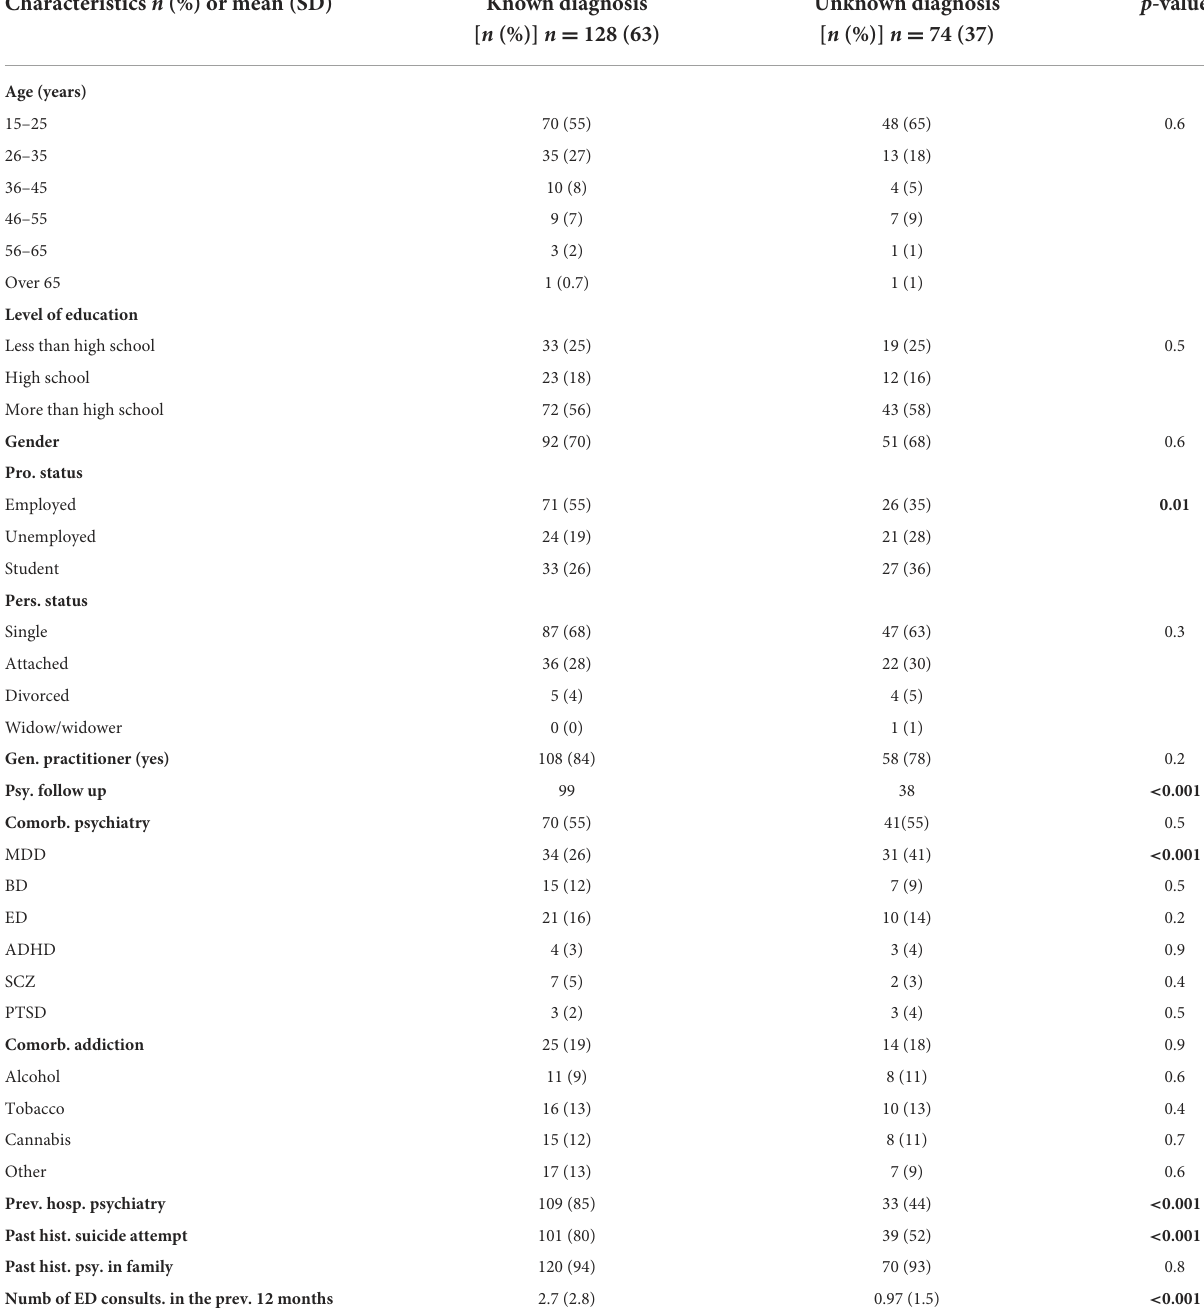
TABLE 1 Comparison between sociodemographic and clinical characteristics based on knowledge of a BPD diagnosis. Characteristics n (%) or mean